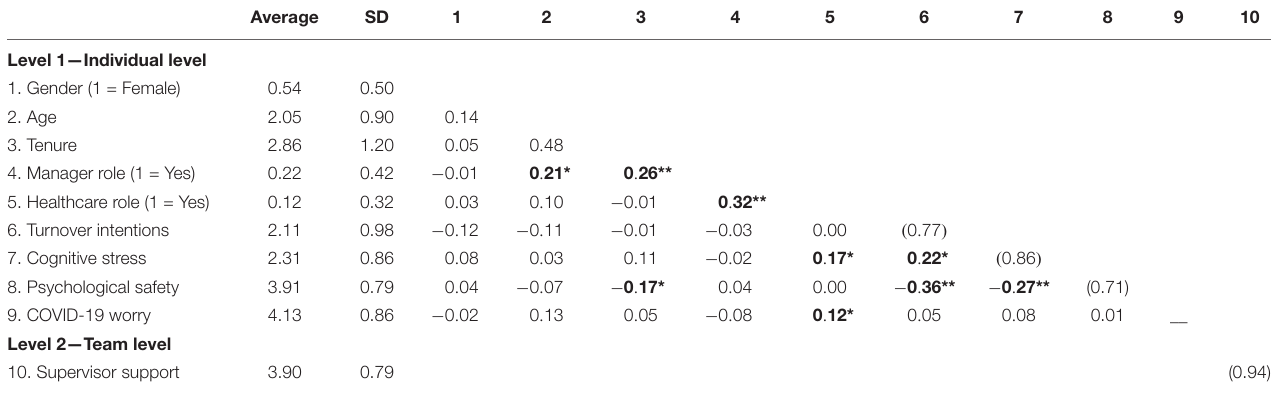
TABLE 3 | Multilevel mediation analysis random-intercept-only model.